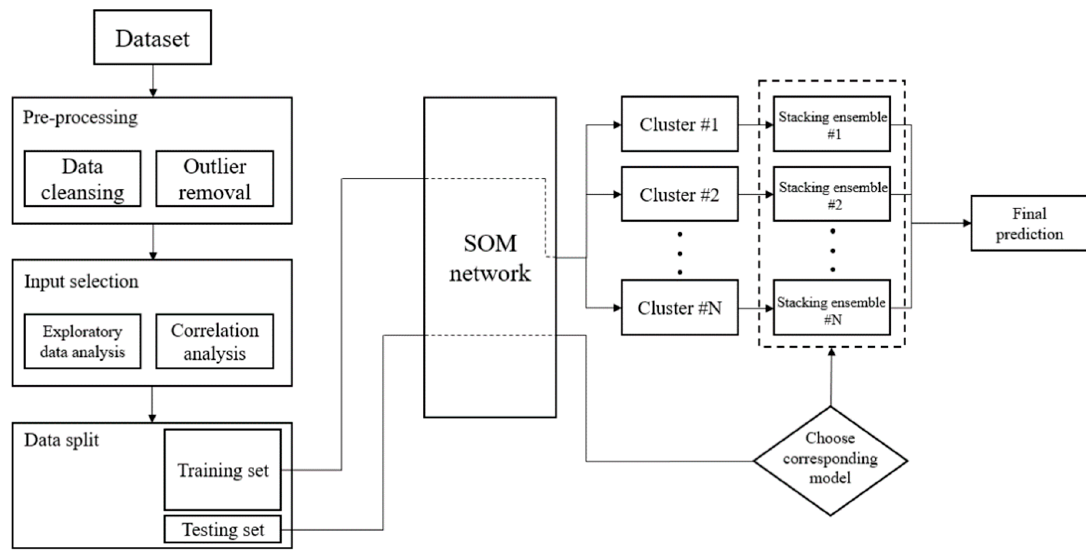
Figure 4. The proposed framework that describes the whole process from data pre-processing to final prediction produced by clustering using SOM and the stacking ensemble learning method.